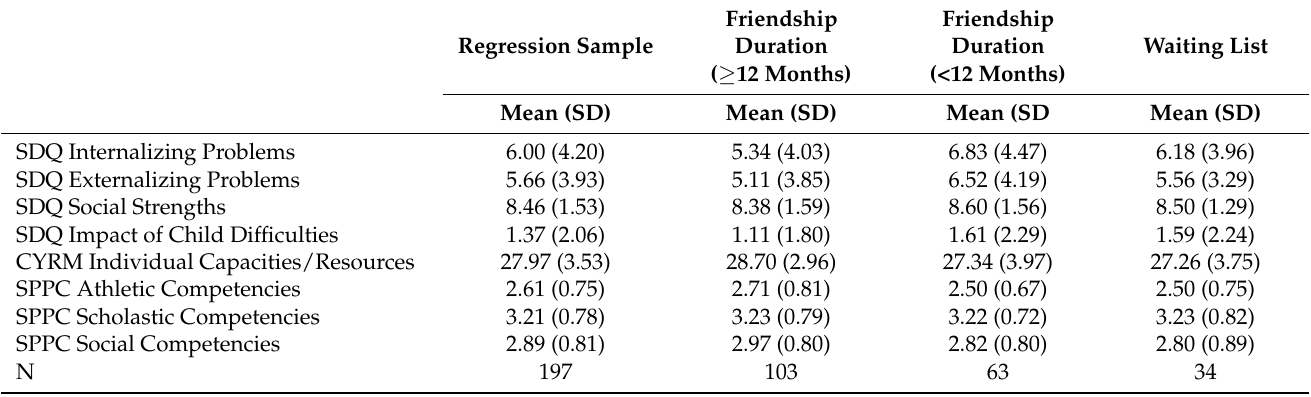
Table 2. Means and Standard Deviation of the Eight Well-being Outcomes Across Samples. Regression Sample